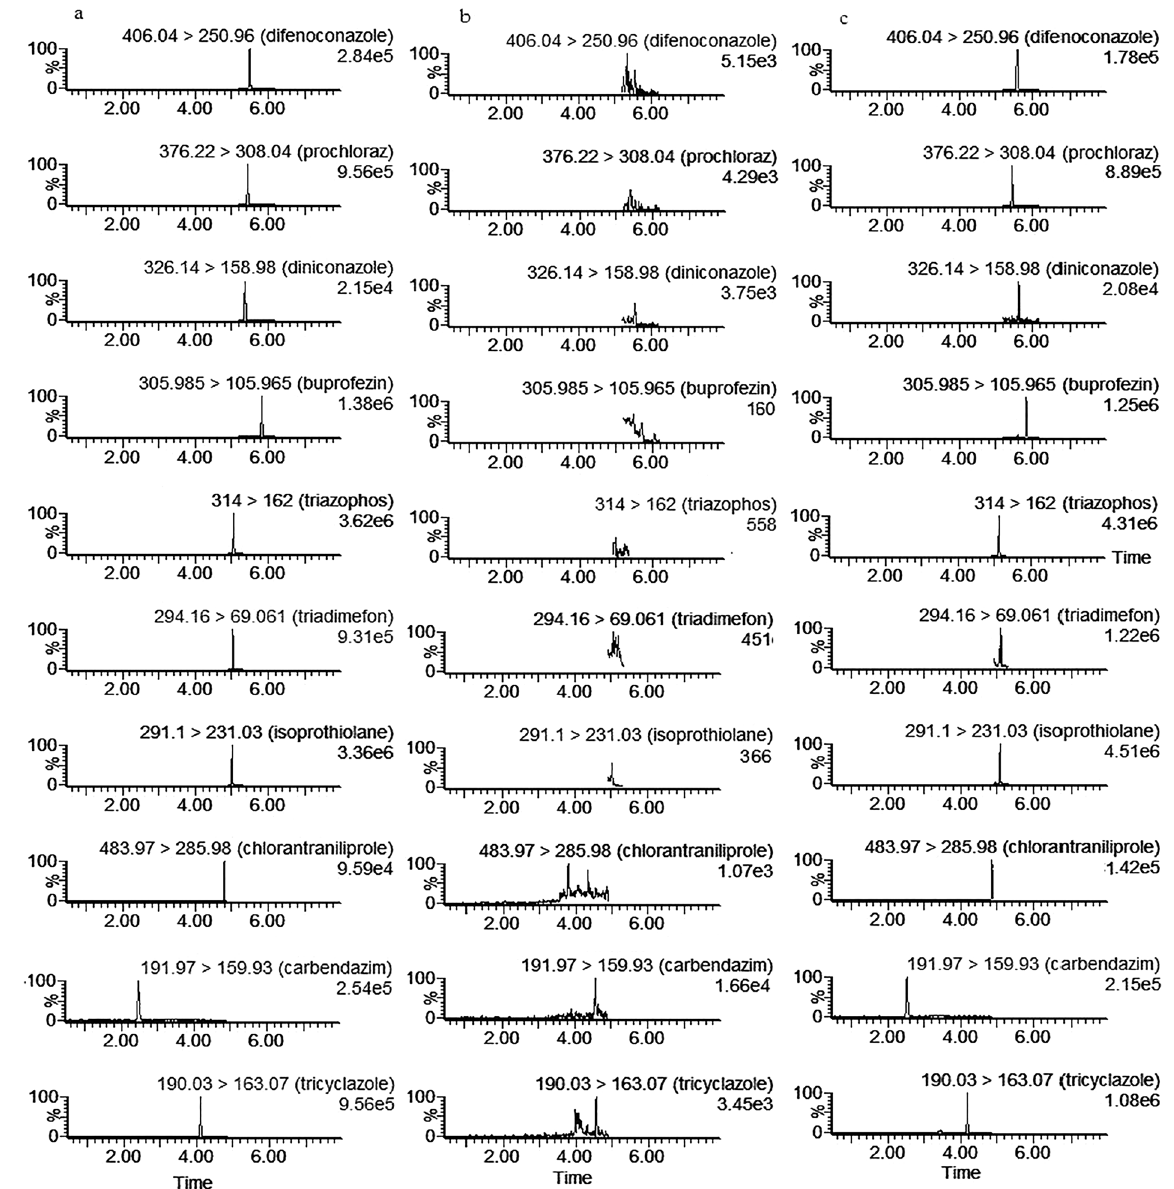
Figure 4. Representative MRM chromatograms of a working standard solution (1.0 μ g/l for the 25 pesticides except fenaminosulf, procymidone and hexaconazole) ( a ), a blank sample ( b ) and a spiked blank sample (0.01 mg/kg for the 25 pesticides except fenaminosulf, procymidone and hexaconazole) ( c